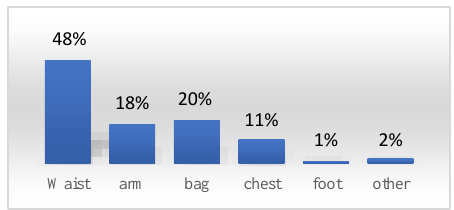
Figure 2. The smartphone position distribution in the HASC2016 dataset [33].